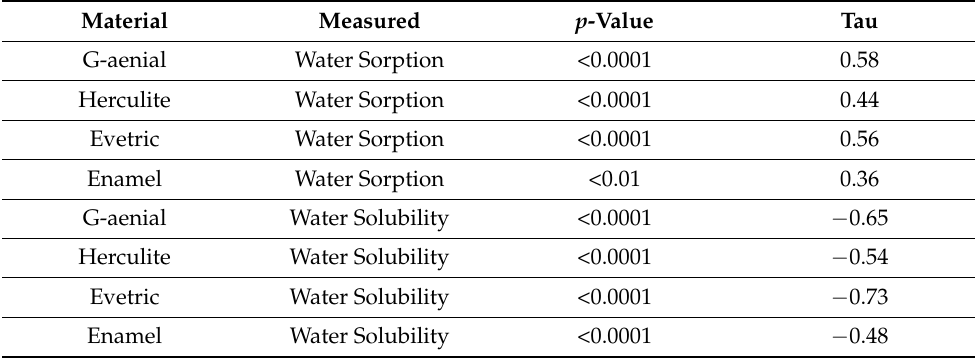
Table 4. Progression of each material through the assessment